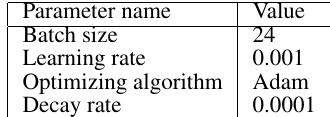
Figure 5. PointNet accuracy versus epoch